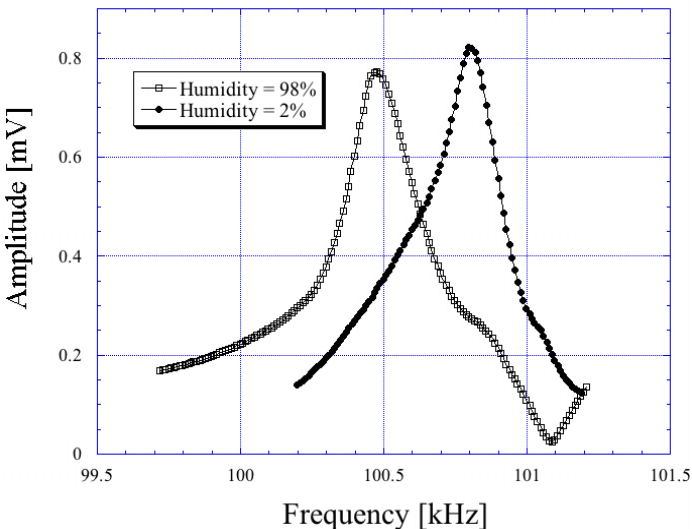
Figure 21. Measured frequency spectrum of magnetoacoustic humidity sensor (magnetoelastic humidity sensor excited by magnetic field and monitored acoustically) at high and low humidity levels (steady state response). Reprinted with permission from